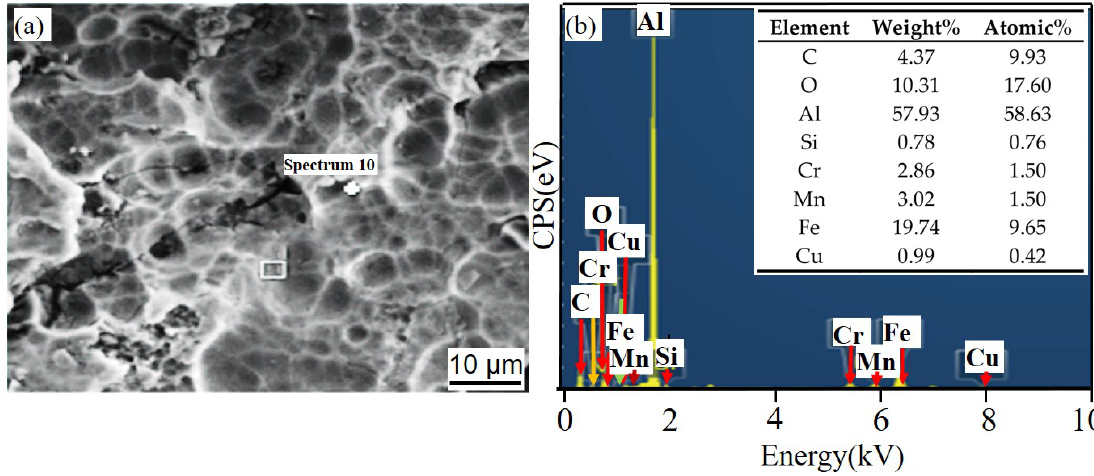
Figure 25. EDS of 6061Al alloy in corrosion pit after SL for 150 days. ( a ) SEM image of corrosion pit; ( b ) EDS of corrosion pit.